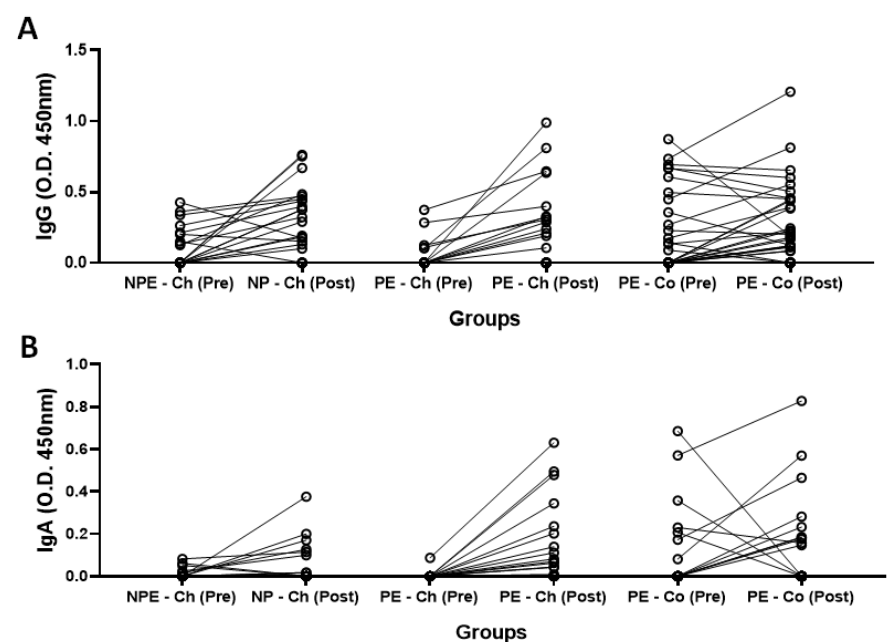
Figure 5. Representation of the antibody response of each volunteer, in terms of the serum concentra- tion (O.D. 450 nm) of specific IgG ( A ) and IgA ( B ) for SARS-CoV-2 antigens before (pre) and after 30 days (post) of administration of the second dose of ChadOx-1 and CoronaVac vaccine in the groups of older adults who regularly practiced (PE) or not (NPE) a physical exercise program before the pandemic